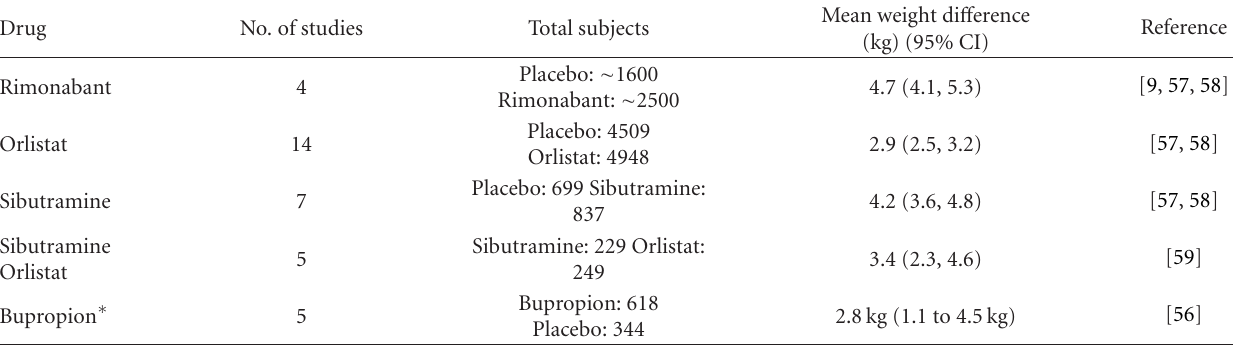
Table 3: Comparative e ffi cacy of pharmacotherapy from recent meta-analyses of long-term studies in adults (12 months or more).